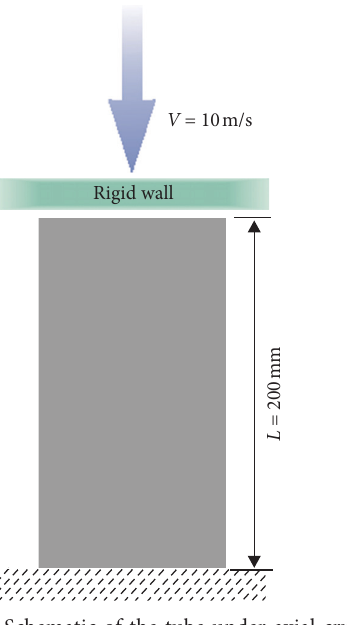
Figure 3: Schematic of the tube under axial crush.